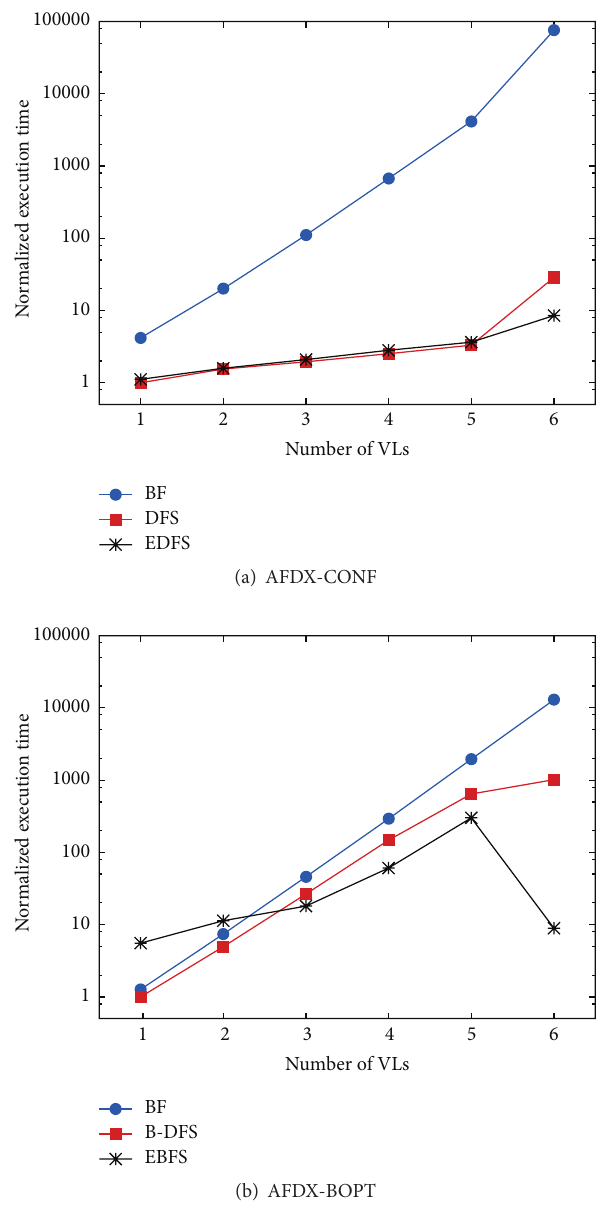
Figure 6: Normalized execution times with respect to the number of virtual